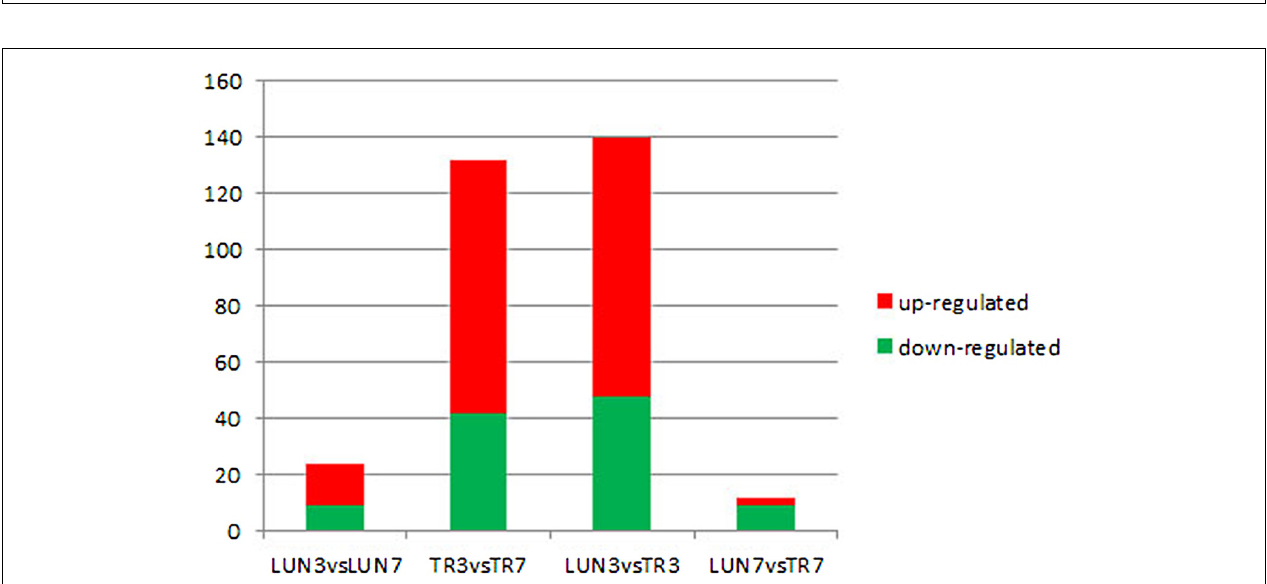
FIGURE 3 | Four comparisons of different post-infection stages, miRNAs showing a differential expression pattern, with down-regulation indicated in green and up-regulation indicated in red.